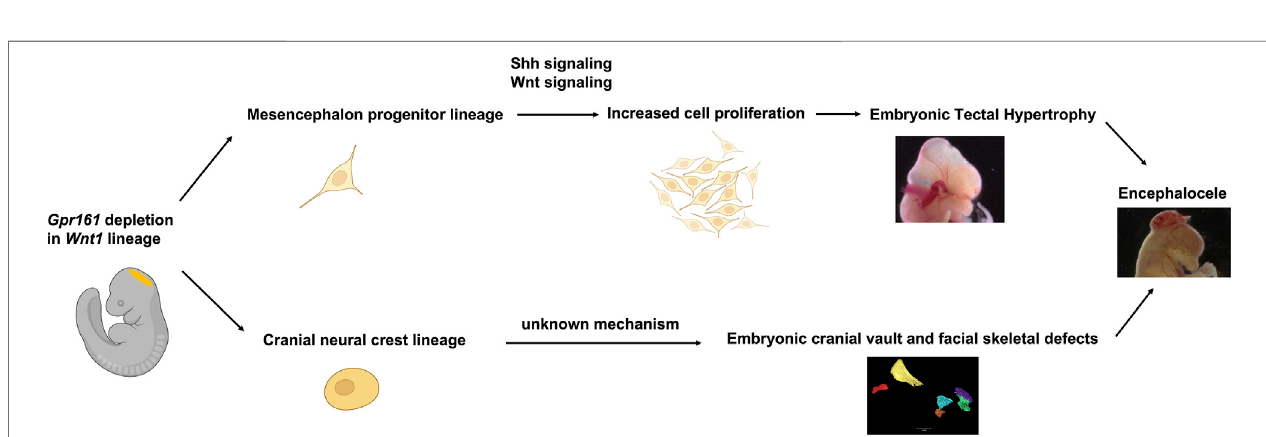
FIGURE6| Schematicsummaryof Gpr161 depletionin Wnt1 -lineagesinmouse.Midbraindorsalneuroectodermderivedmesencephalonprogenitorwith Gpr161 depletion resulted in the increased cell proliferation via up-regulated Shh and Wnt signaling, thereby contributing to embryonic tectal protrusive phenotypes from E13.5. The Gpr161 depleted cranial neural crest cells derived from the mesencephalon caused severe cranial vault and facial bone defects. Both embryonic tectal protrusion and craniofacial bone defects could contribute to encephaloceles. This schematic fi gure was partly created with BioRender.com.